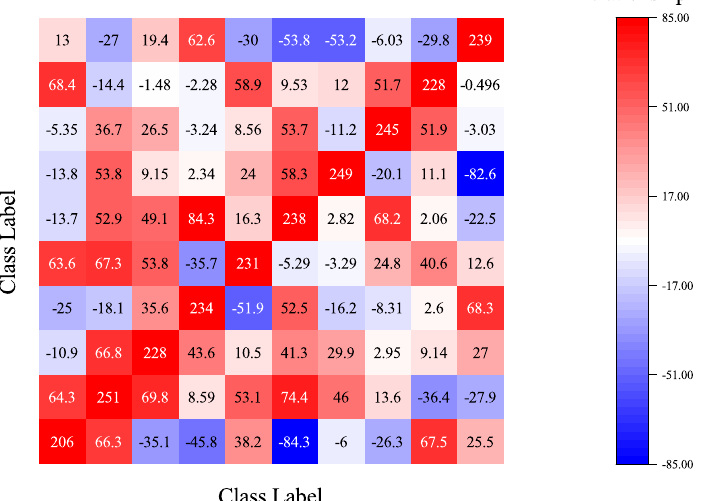
Figure 4. A heat-map visualization of the relationship matrix of a 10-category image classification model. The value in the ij -th box quantifies the relationship between the features of the i -th category and the features of the j -th category, where positive values represent cooperative relationships, while negative values represent competitive relationships.